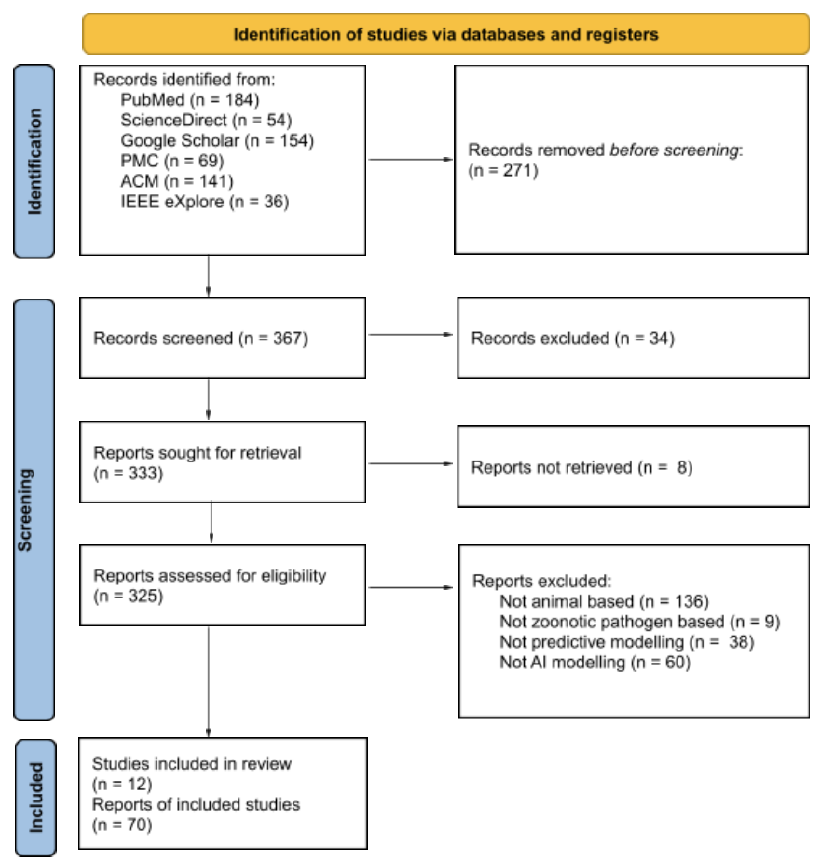
Figure 1. A flowchart illustrating a selection of manuscripts for inclusion in this review based on Preferred Reporting Items for Systematic Reviews and Meta-Analyses